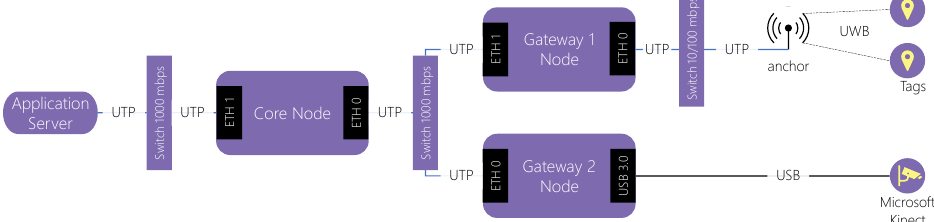
Figure 6. End-to-end network structure employed in the